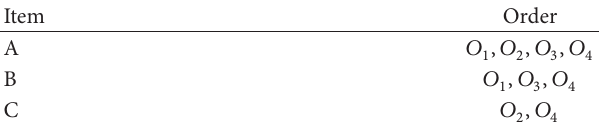
Table 2: Item-order